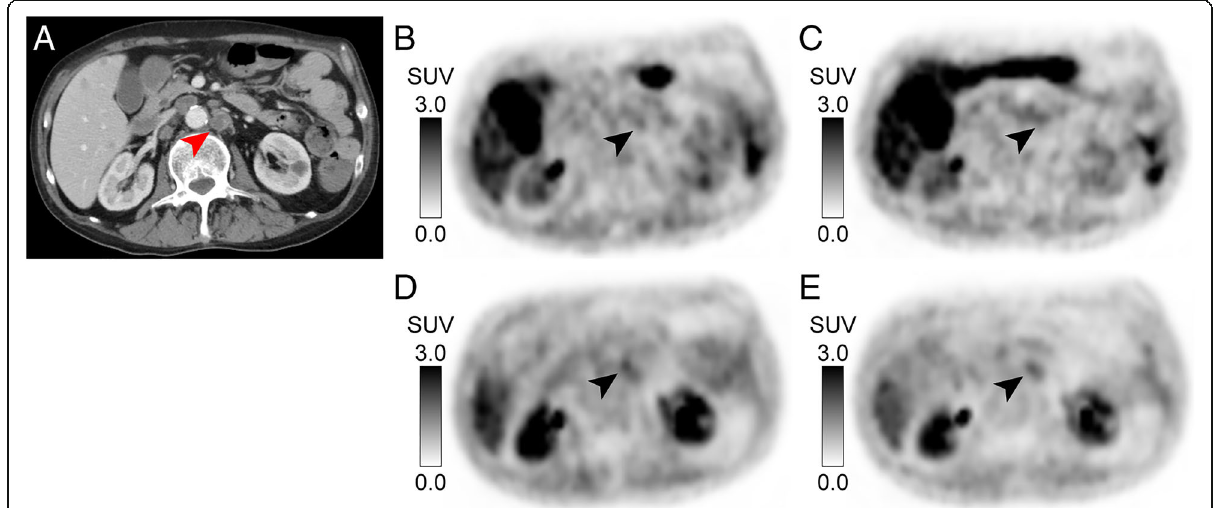
Fig. 6 Representative images of a patient. a Transaxial image of contrast-enhanced CT. The swollen paraaortic lymph node is shown. b , c 2-h and 4-h images with [ 18 F]FMISO. d , e 1-h and 2-h images with [ 18 F]DiFA. Tracer uptake to the lymph node metastasis of rectal adenocarcinoma is clearly detected in all images. The contrast at 1 h and 2 h with [ 18 F]DiFA (TMR = 1.25 and 1.37, respectively) is better than that at 2 h with [ 18 F]FMISO (TMR = 1.09) and equivalent to 4-h [ 18 F]FMISO (TMR =